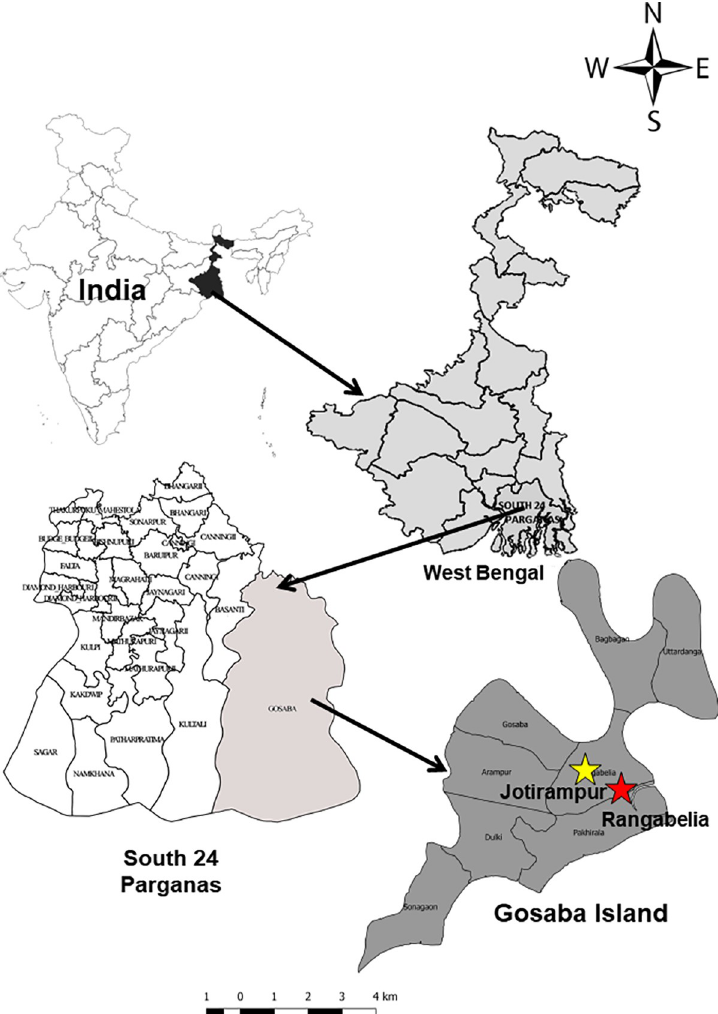
Fig 1. Location of the study [the figure is drawn from the CIA (public domain) (https://www.cia.gov/library/ publications/the-world-factbook/index.html) that complies with the CC BY 4.0 license. The figure is similar but not identical to the original image and, therefore, for illustrative purposes